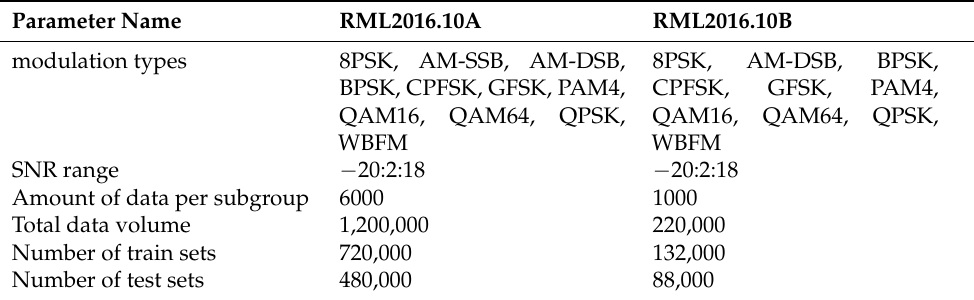
Table 6. Datasets comparison.